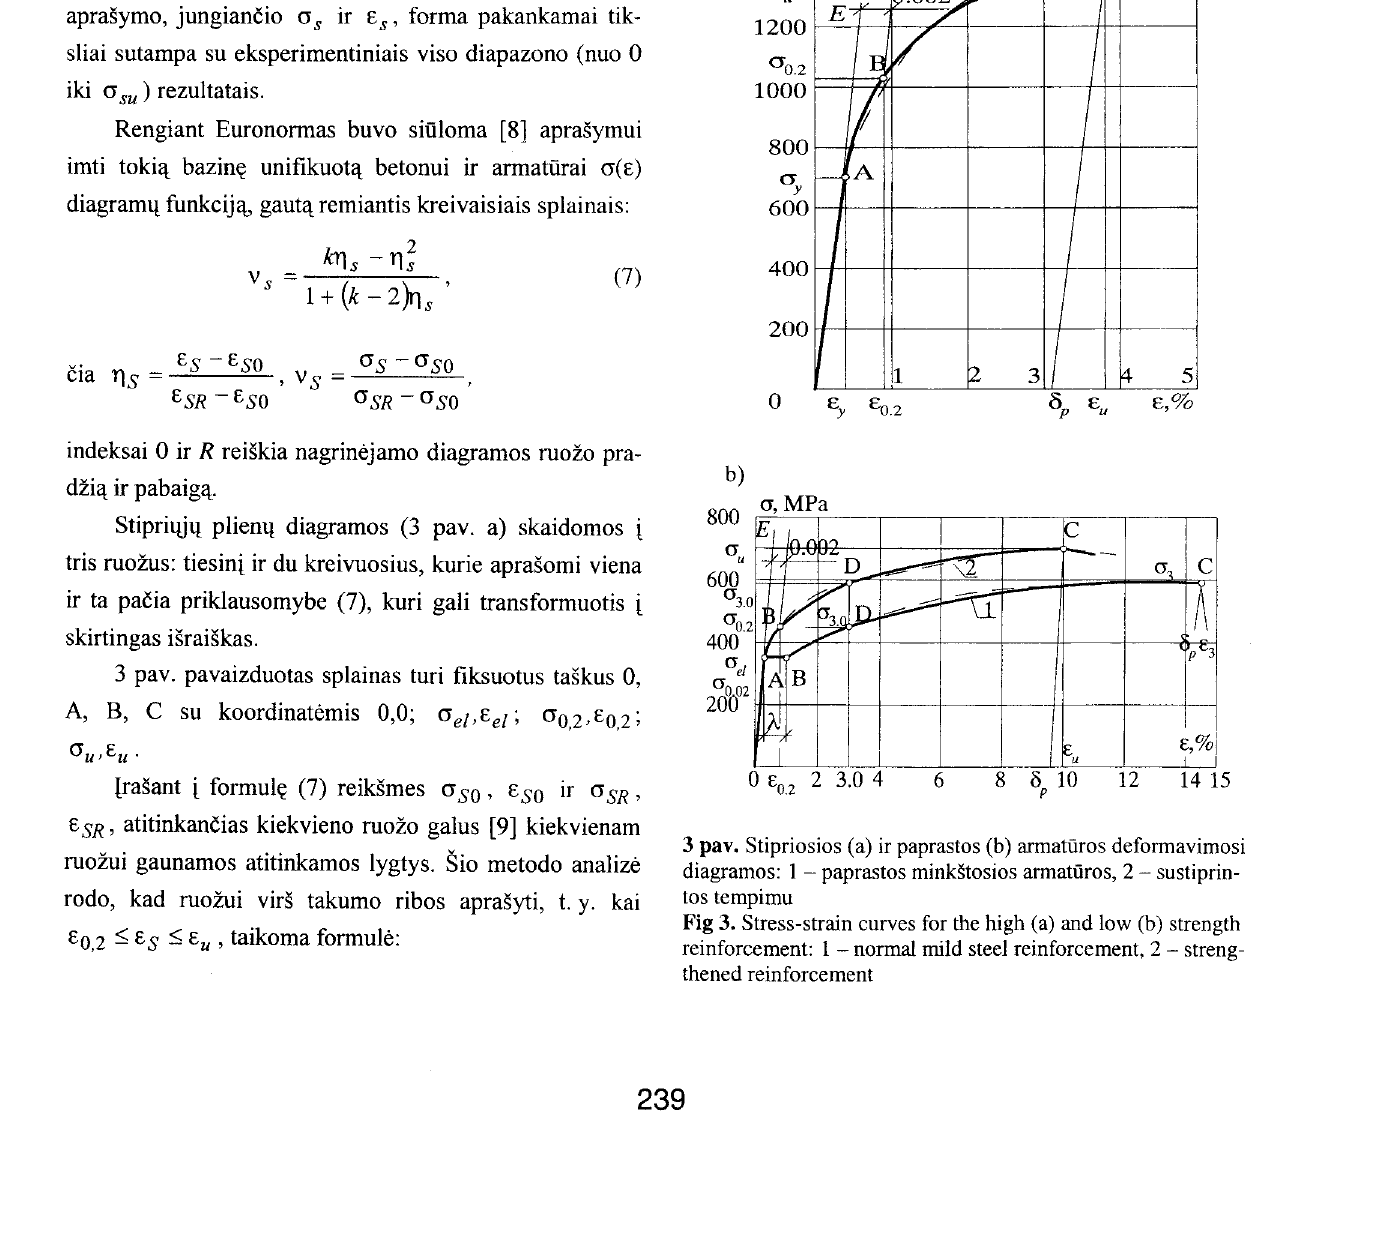
3 pav. pavaizduotas splainas turi fiksuotus taskus 0, A, B, C su koordinatemis 0,0; Oez,Eet; oo,2,Eo,2;